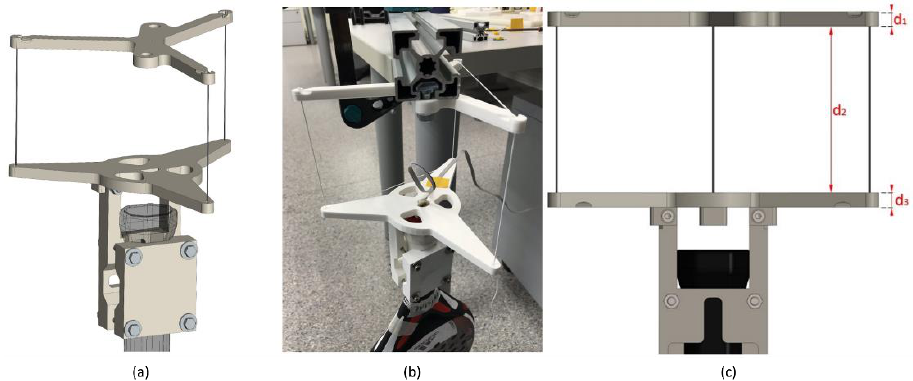
Figure 7. Setup for the vertical rotation. ( a ) CAD model, ( b ) final assembly, and ( c ) detail of strings. The padel rackets are mounted between two polylactic acid (PLA) 3D-printed compo- nents; the cradle and the holder are shaped like the handle of